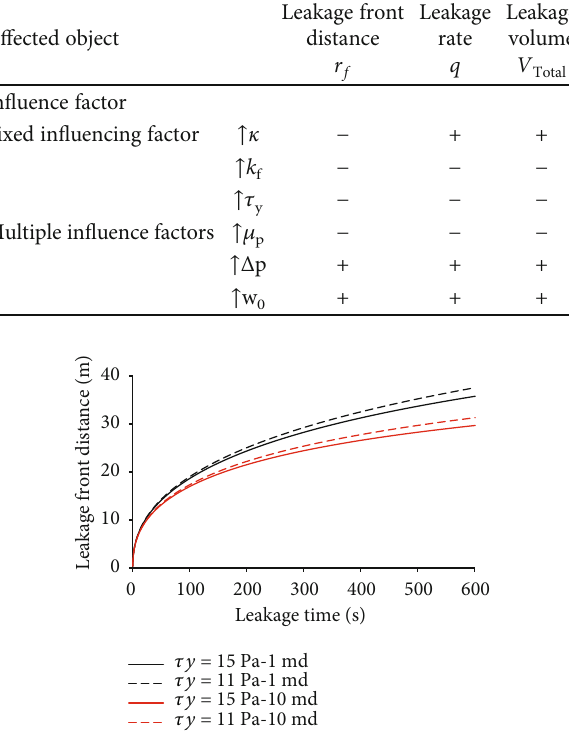
Figure 13: Leakage front distance under di ff erent formation permeability and yield stress.